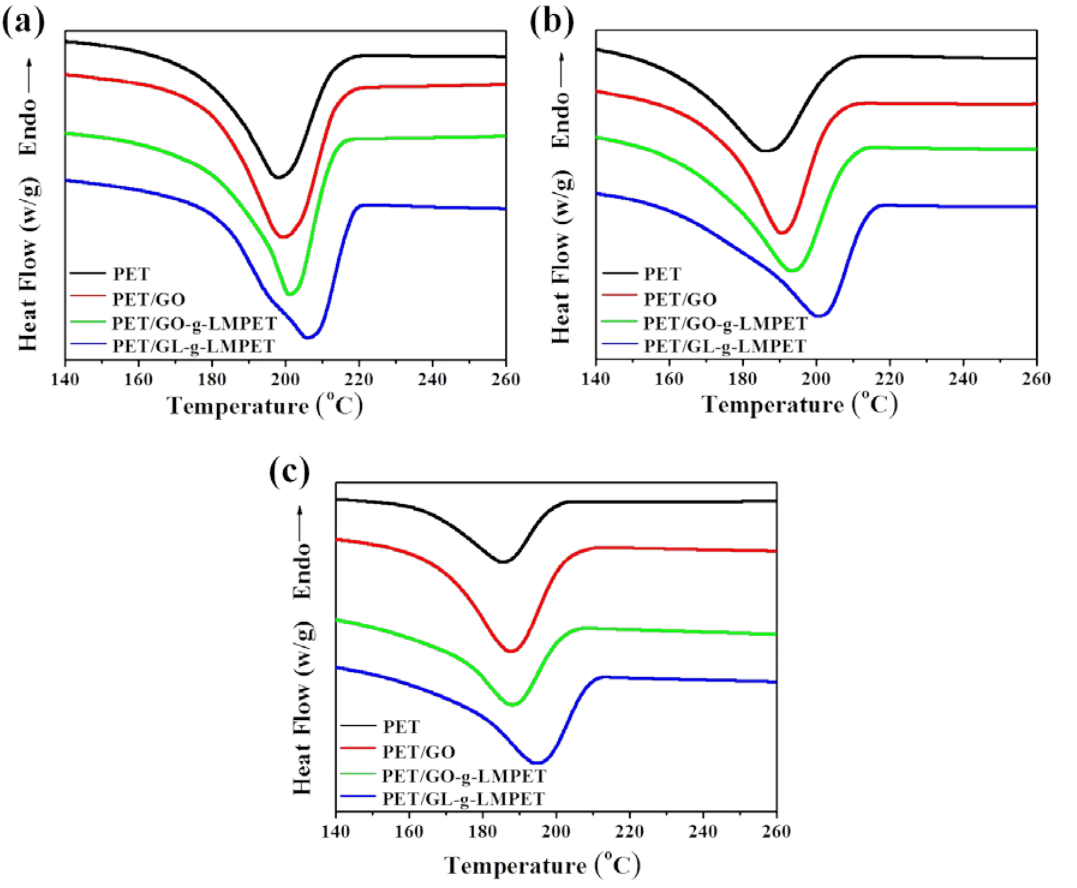
Figure 9. DSC curves for pure PET, PET/GO, PET/GO- g -LMPET and PET/GL- g -LMPET at different cooling rates. ( a ) 5 °C ·min −1 ; ( b ) 15 °C ·min −1 and ( c ) 20 °C ·min −1 .